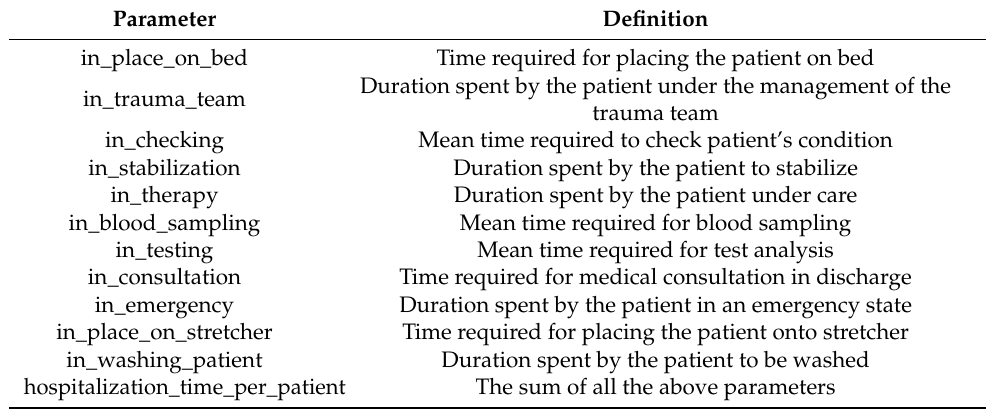
Table 1. Time-related